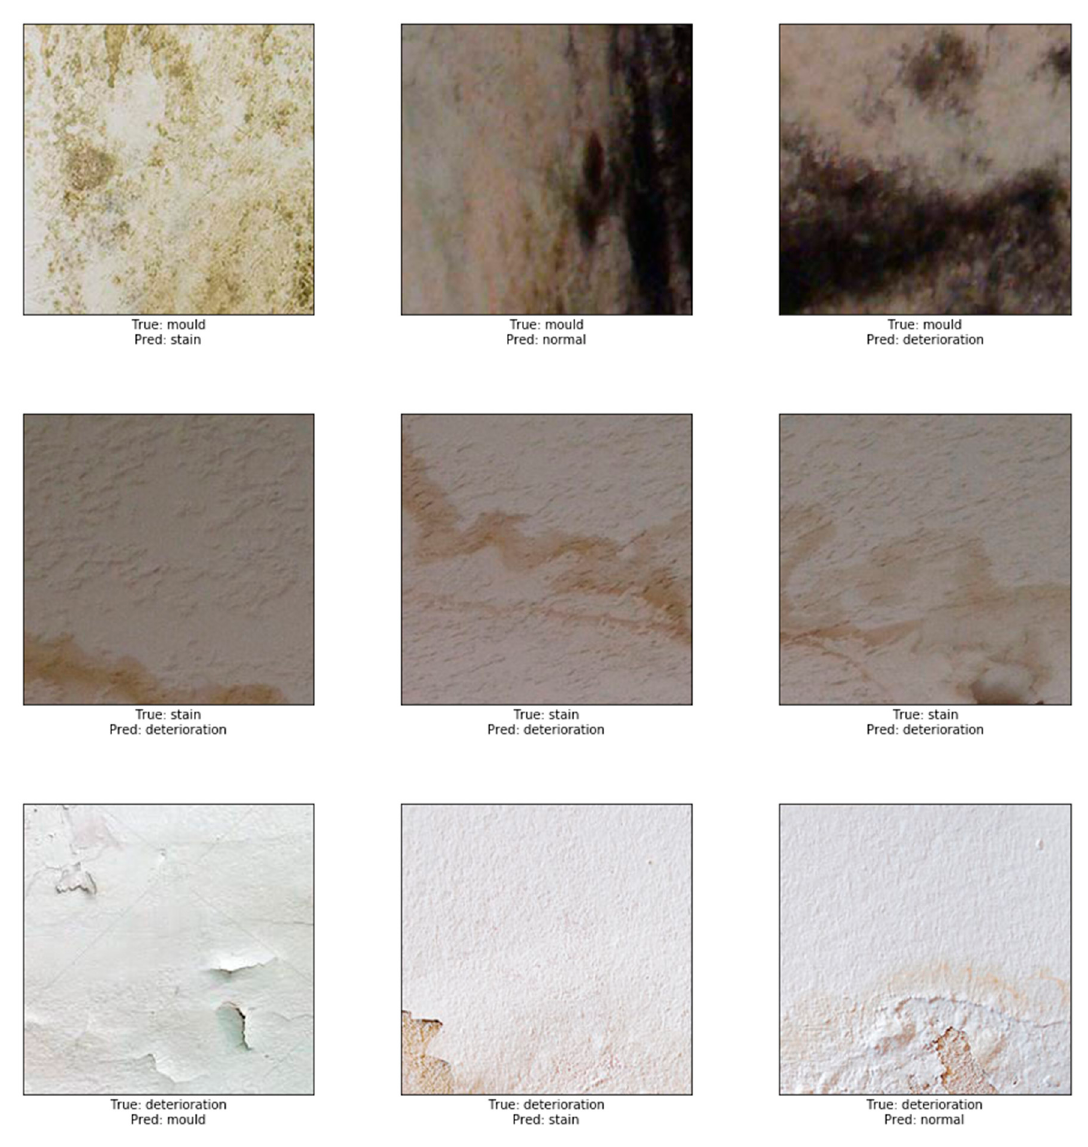
Figure 7. Example of misclassification.